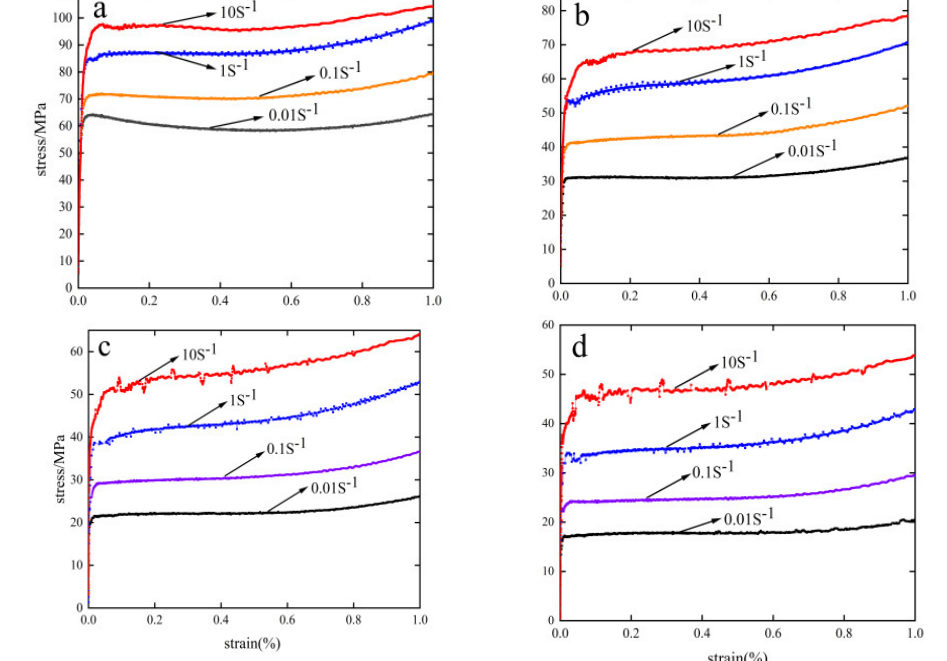
Figure 1. Real stress － strain curves: ( a ) 613.15 K, ( b ) 663.15 K, ( c ) 713.15 K, ( d ) 763.15 K.